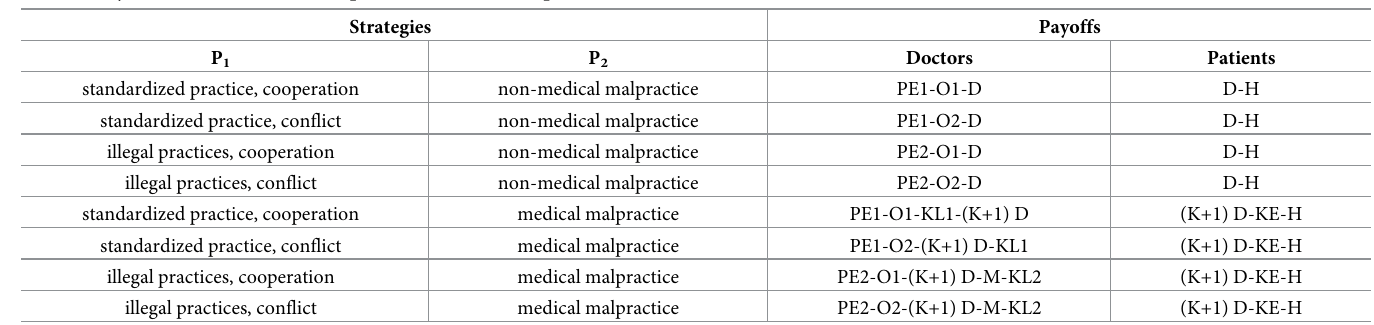
Table 1. Payout matrix for doctors and patients in medical